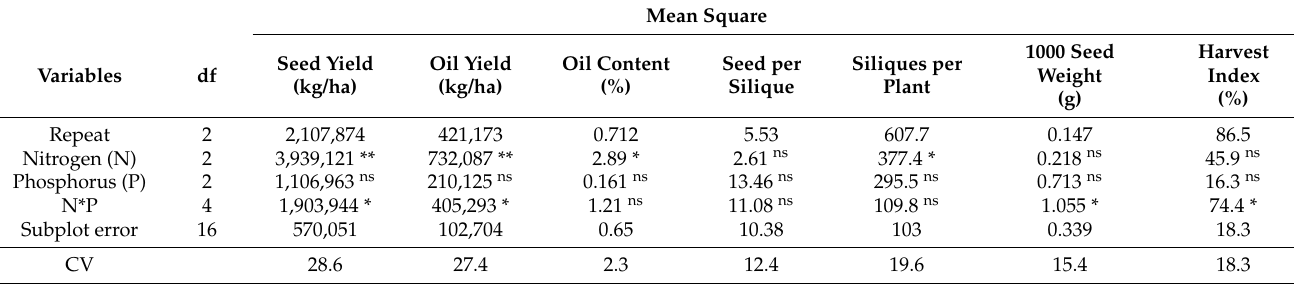
Table 3. Variance analysis of yield and yield components of rapeseed under N and P